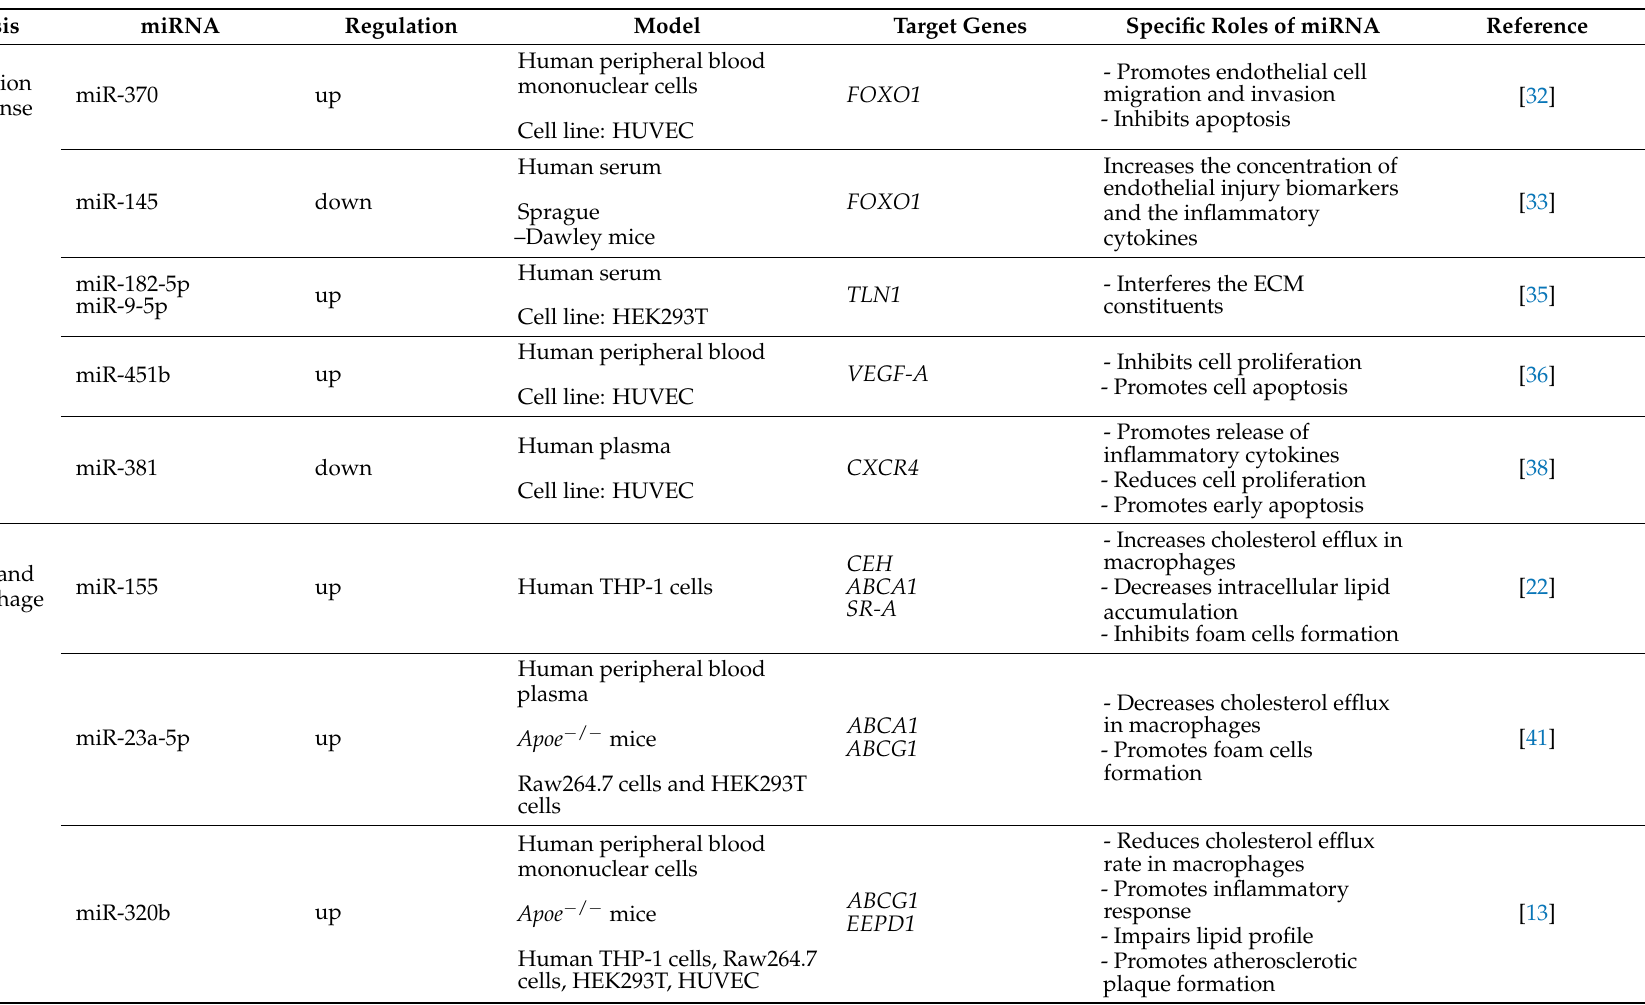
Table 1. Role of miRNAs in ischemic heart